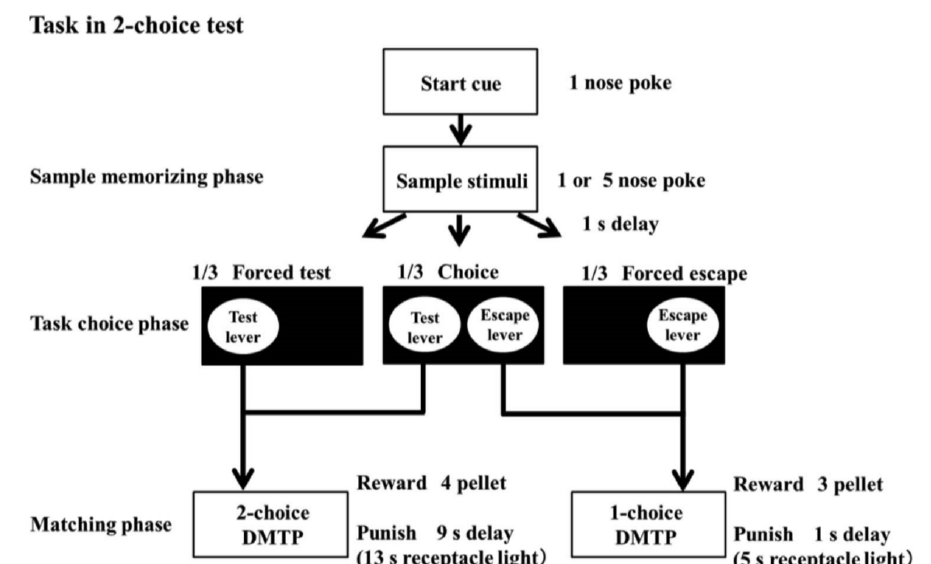
Figure 1 . Schematic representation of the two-choice metacognitive task applied in Yuki and Okanoya (2017) (NP = nose poke; DMTP = delayed matching to position). Adapted from Figure 2 in Yuki, S., & Okanoya, K. (2017). Rats show adaptive choice in a metacognitive task with high uncertainty. Journal of Experimental Psychology: Animal Learning and Cognition, 43, 109 –